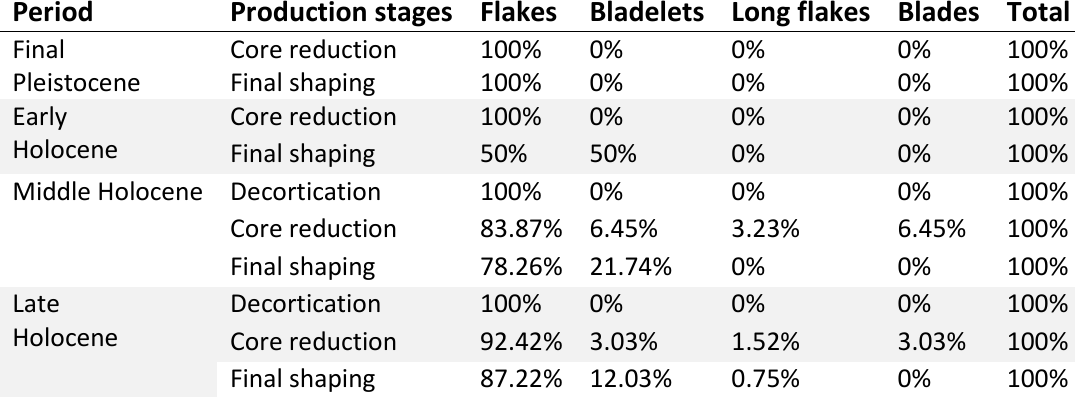
Table 7. Proportion of flake classes in each stage of production.